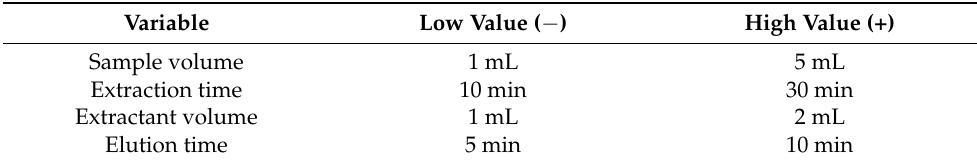
Table 2. Low and high values for the optimized variables of